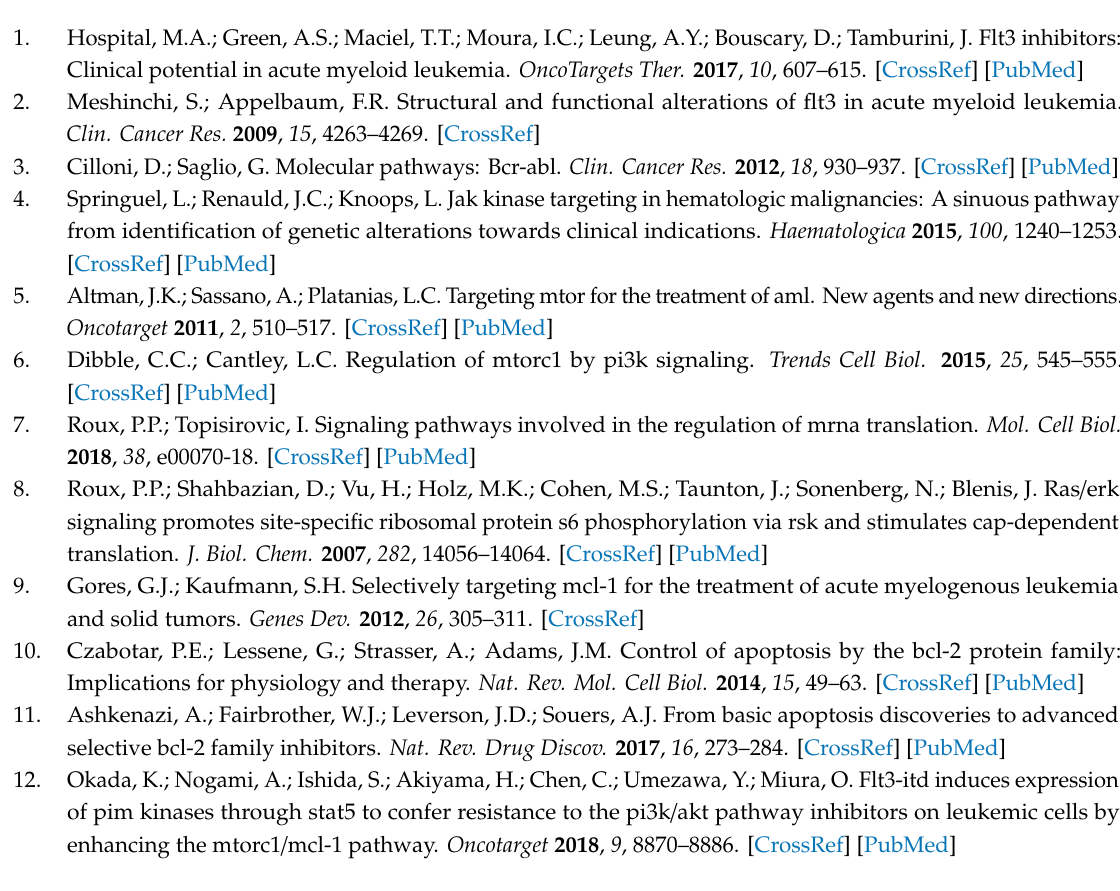
Figure S1. E ff ects of RSK inhibitors on proliferation of cells transformed by FLT3-ITD, BCR / ABL, or JAK2-V617F; Figure S2. RSK1 negatively regulates Bad and BIM-EL and activates the mTOR pathways and eIF4B cooperatively with PIM in FLT3-ITD-positive AML cells; Figure S3. Inhibition of RSK and PIM or PI3K cooperatively activates the intrinsic